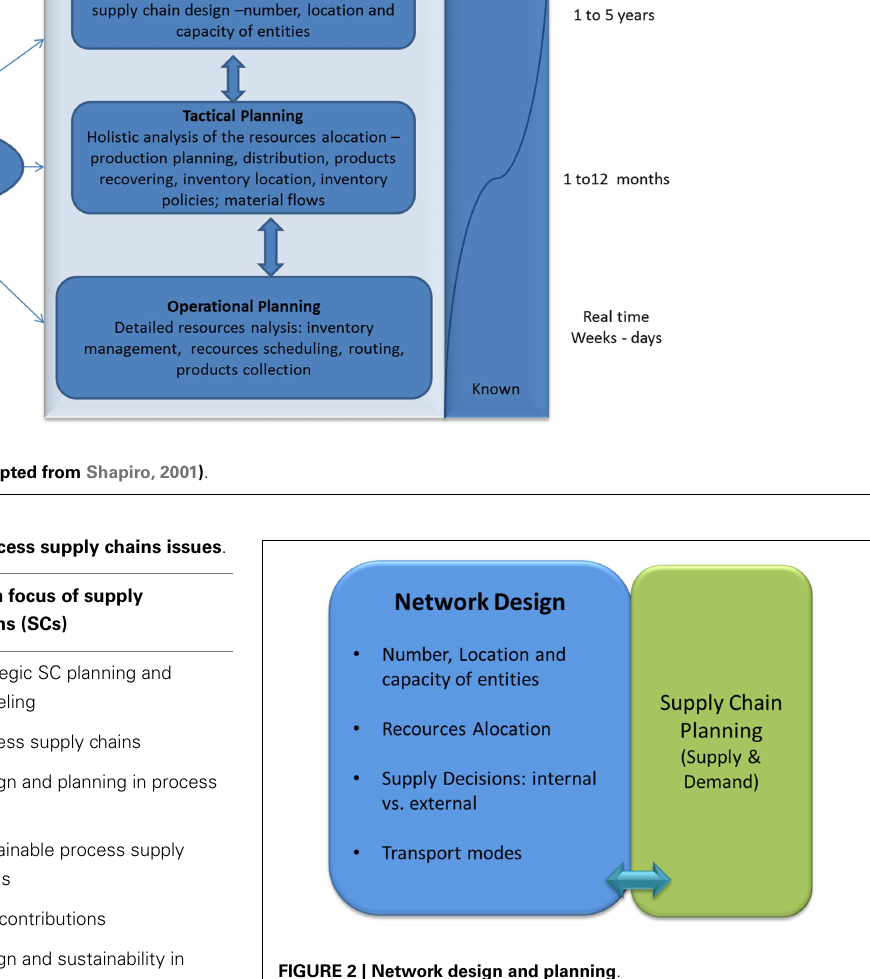
FIGURE 2 | Network design and planning